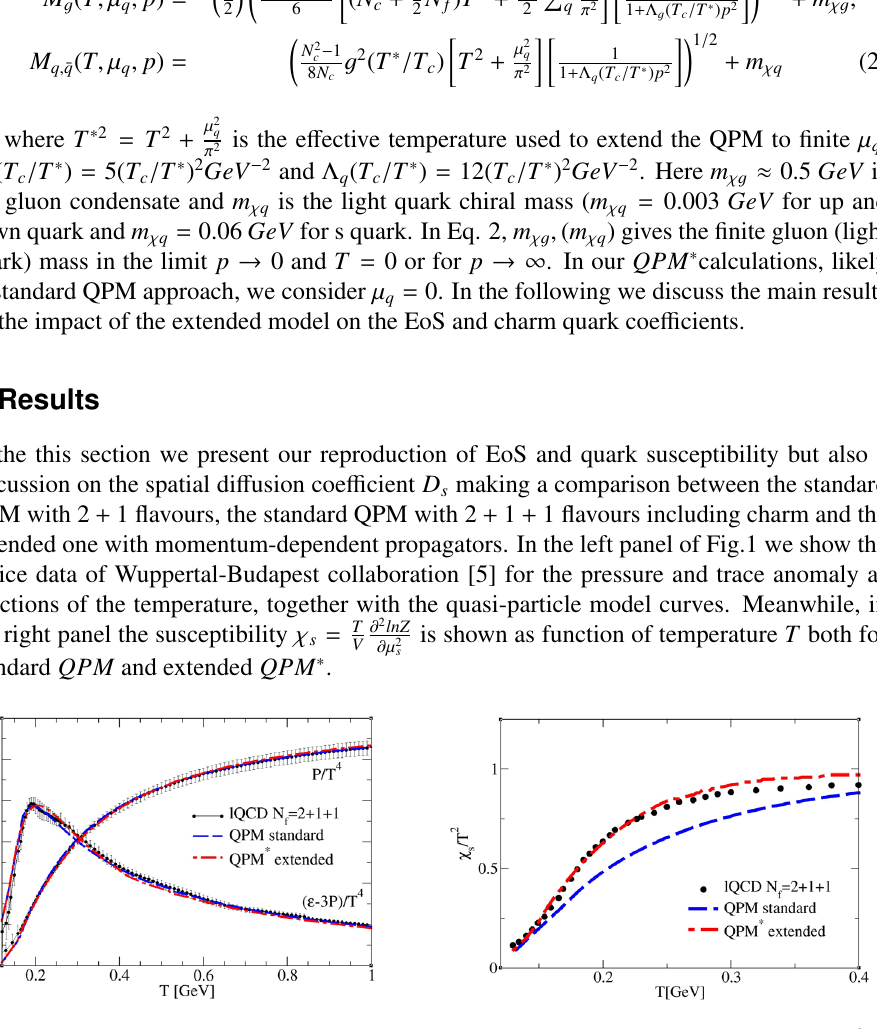
Figure 1. Pressure P / T 4 and interaction measure ( (cid:23) (right panel) for standard QPM and extended QPM ∗ with N f = 2 + 1 + 1. The lattice data of the Wuppertal-Budapest collaboration are taken from Ref.